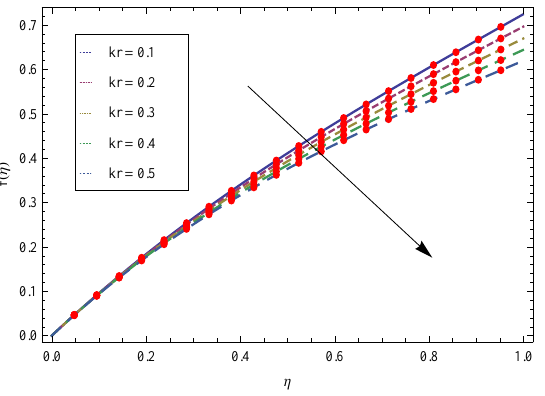
Figure 9. The effect of λ on θ ( η ) , when h = − 0.6, S = 0.5,kr = 0.5,Pr = 0.5,Ec = 0.5,Nb = 0.5, Nt = 0.6, β = 1, Sc = 0.6.